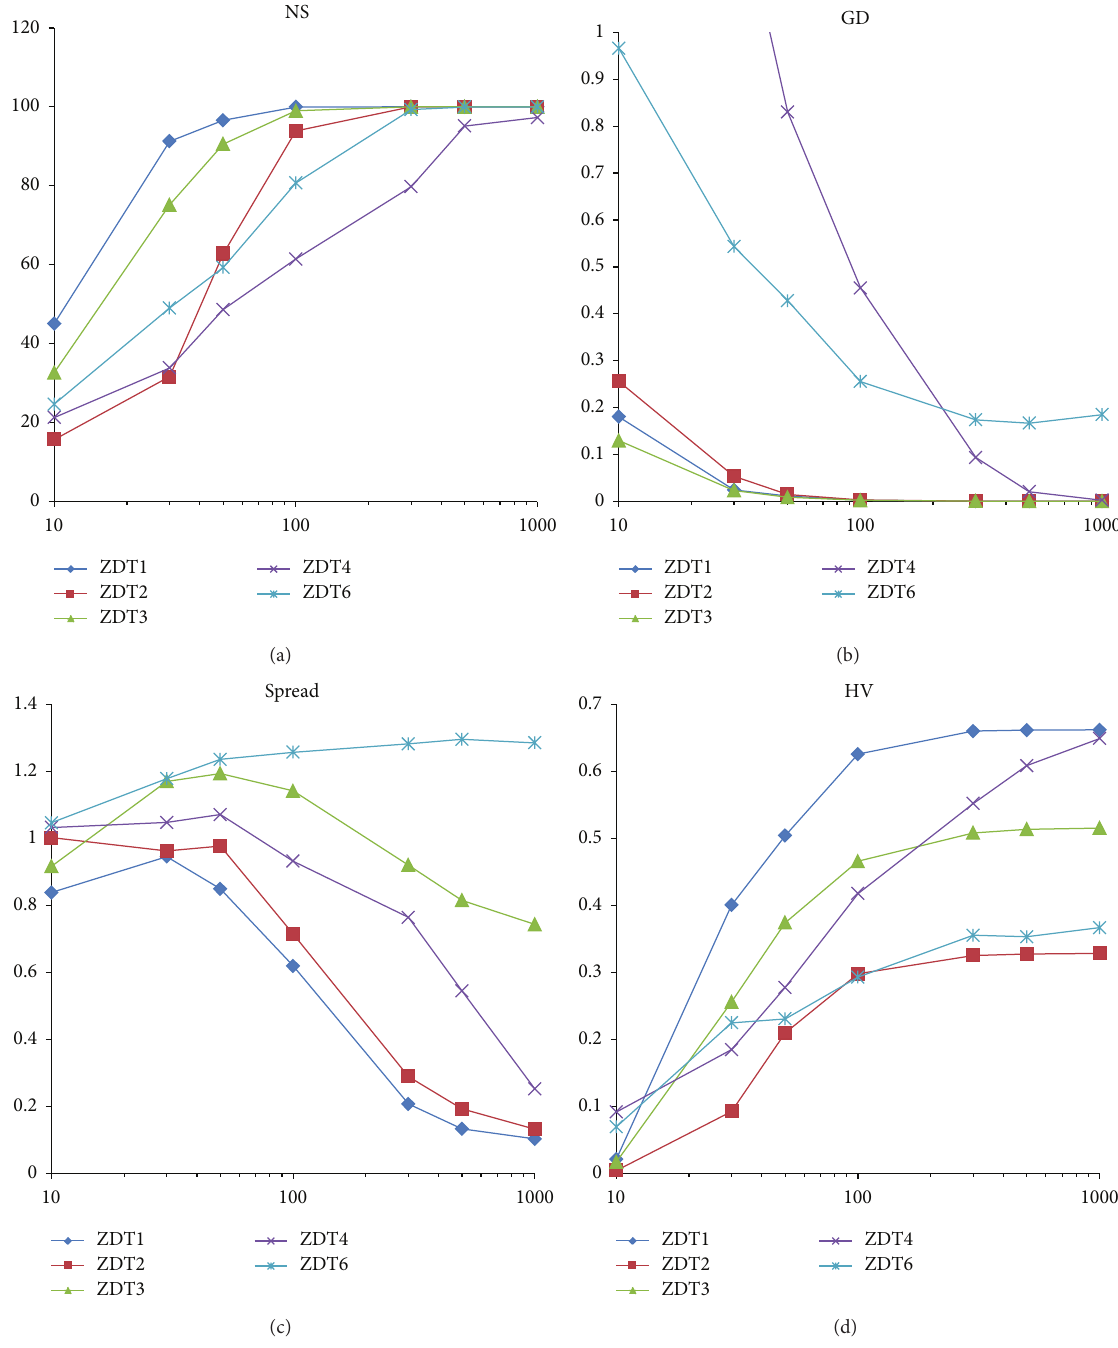
Figure 10: Plots of the performance metrics for various numbers of particles. (a) Number of solutions. (b) Generational distance. (c) Spread. (d)